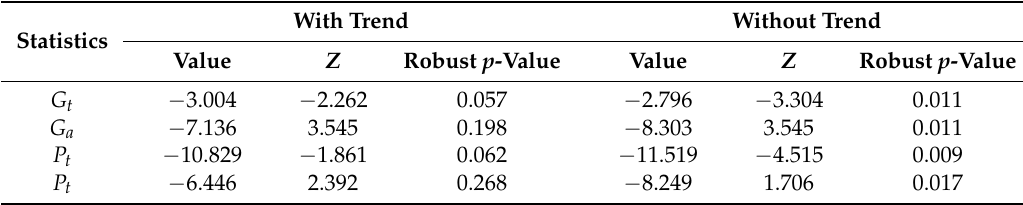
Table 3. Results of Panel Cointegration